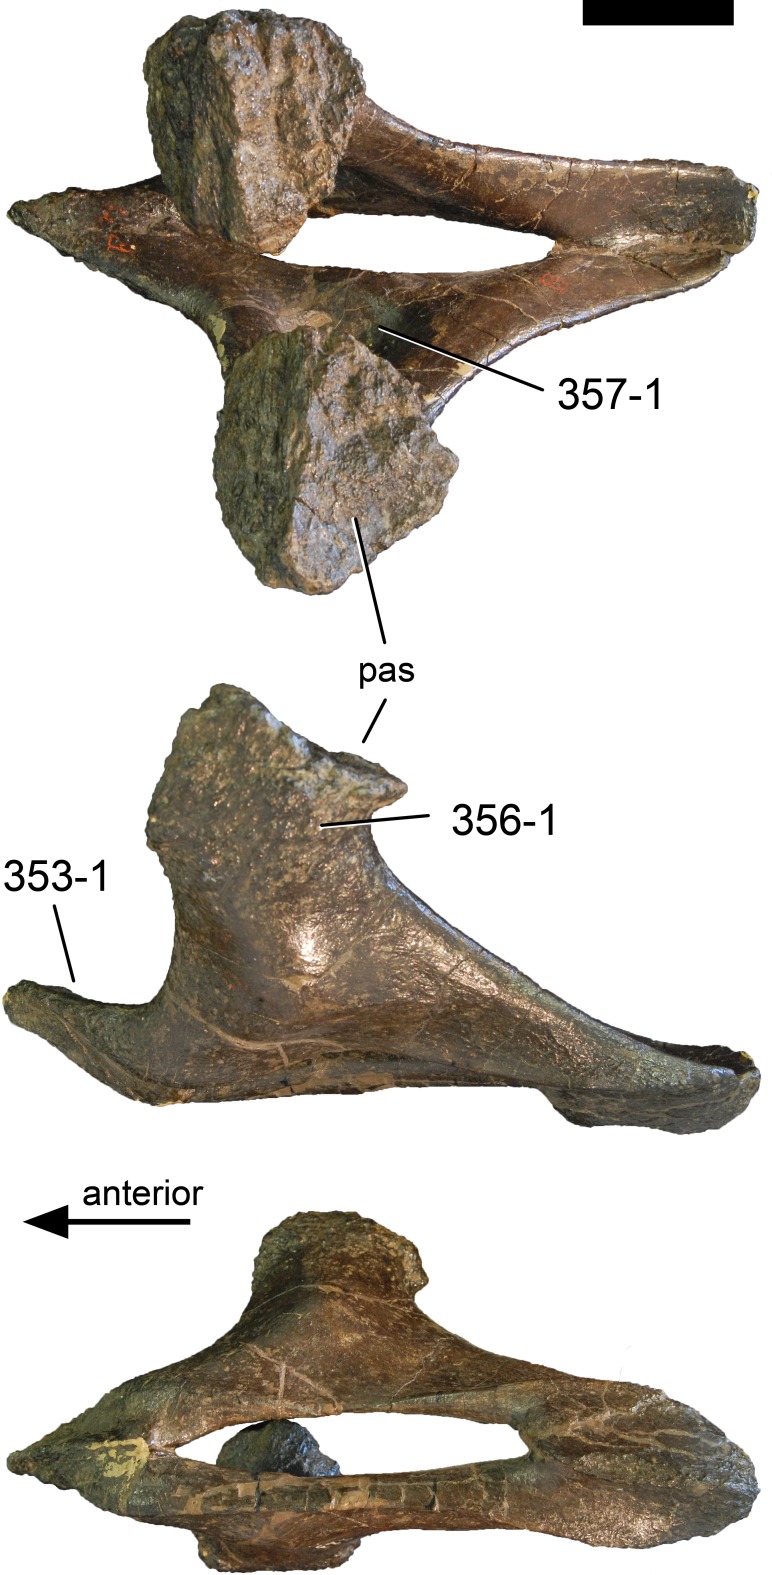
Mid-chevron of Diplodocus hallorum AMNH 223 in dorsal, left lateral, and ventral view (top-bottom).Note the anterior and posterior projections (C353-1), the rugose horizontal ridge (C356-1), and the medial fossa (C357-1). Abb.: pas, proximal articular surface. Scale bar = 5 cm.